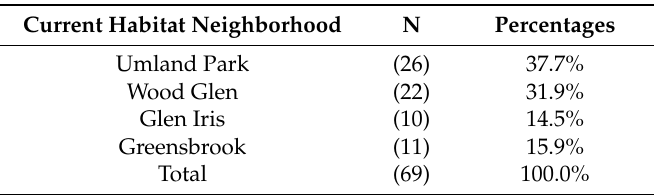
Table 1. Houston Habitat Neighborhoods.